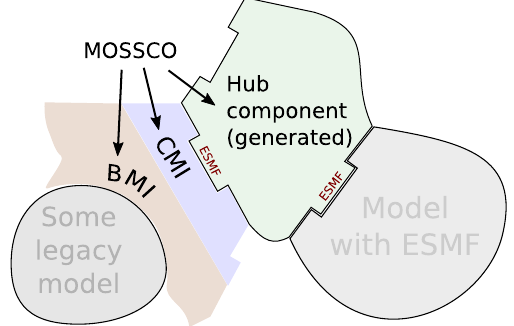
Figure 1. MOSSCO’s adoption of legacy code follows the two-layer paradigm of BMI–CMI (basic model interface–component model interface) suggested by Peckham et al. (2013). An existing legacy code (illustrated by “some model”) is enhanced by model-specific code that exhibits basic coupling functionality (BMI) and is frame- work agnostic. In a second step, a component (CMI) is added that uses the BMI in the specific application programming interface of the coupling framework. In addition to model interfaces that can be used in MOSSCO-independent contexts, MOSSCO provides cou- pling concepts and working implementations for coupled applica-